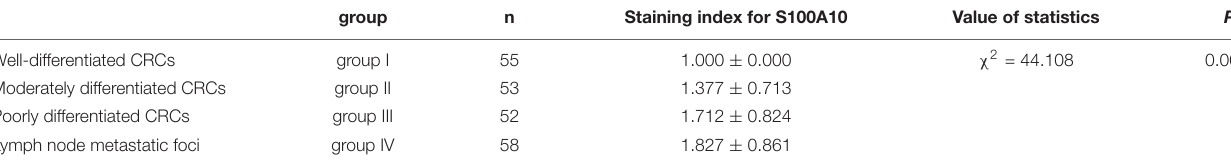
TABLE 2 | Comparison of staining index of S100A10 nuclear expression in human CRC